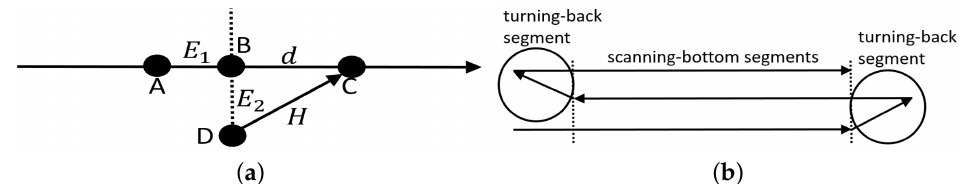
Figure 3. ( a ) A—desired position of the AUV, B—true position of the AUV projected on the trajectory, C—local destination point of the AUV, D—true position of the AUV, H —heading to point C, d — distance from point B to point C, E 1 , E 2 —errors, ( b ) trajectory of the